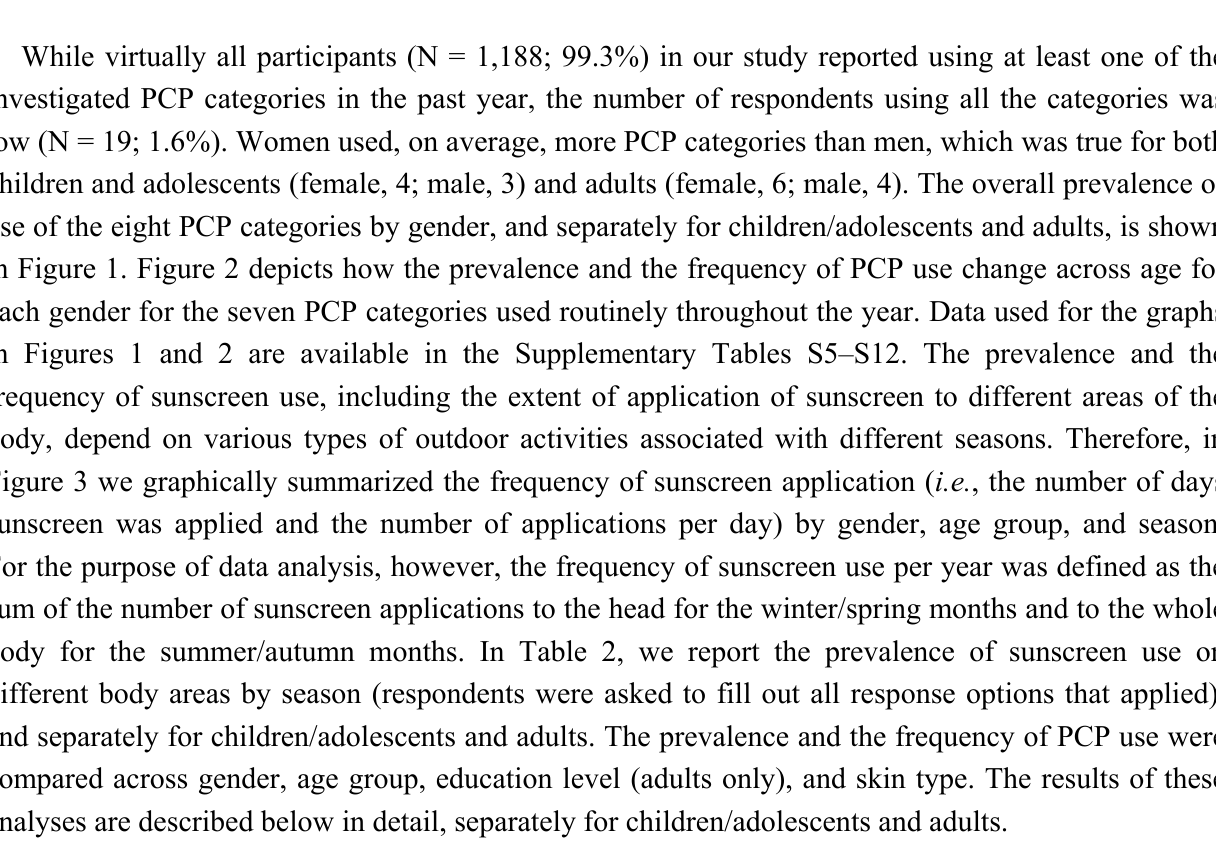
Figure 1. Percentage of PCP users by